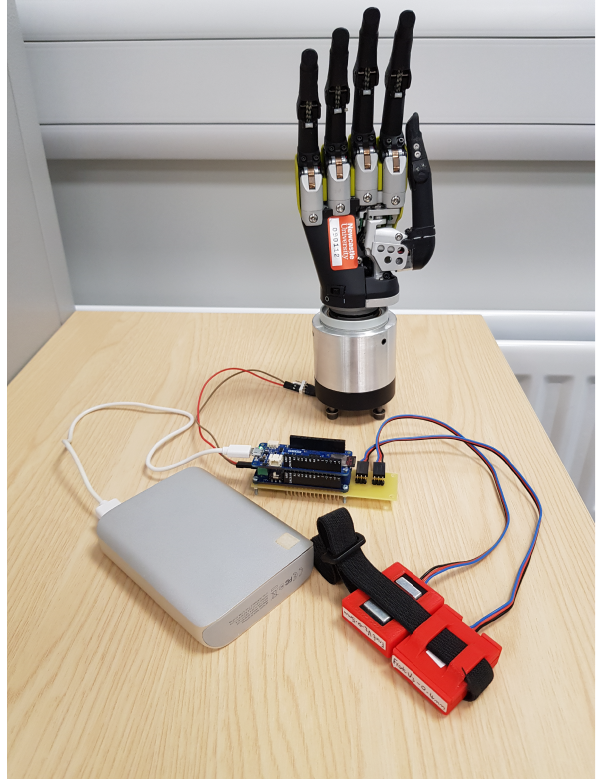
Figure 1. The prototype of the proposed myoelectric control